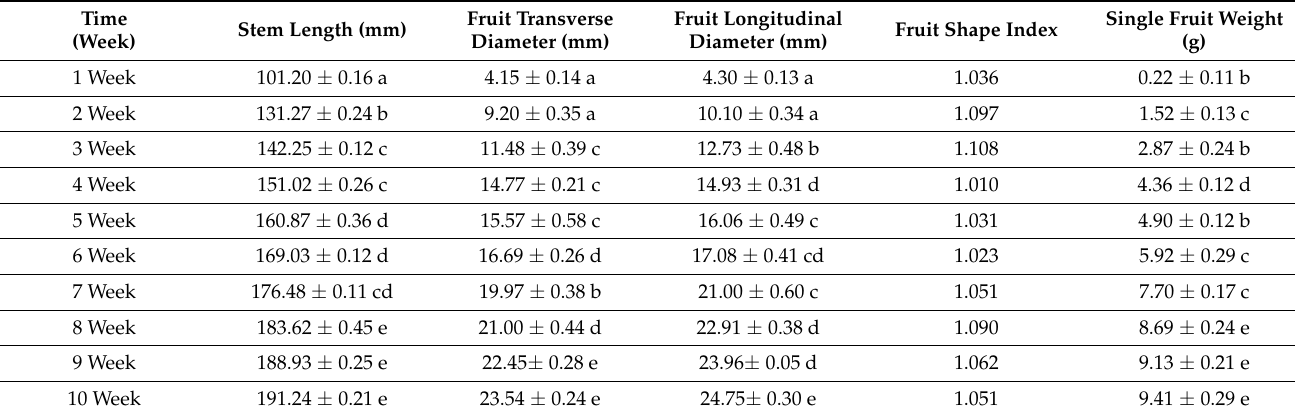
Table 1. Tracked and measured grape growth